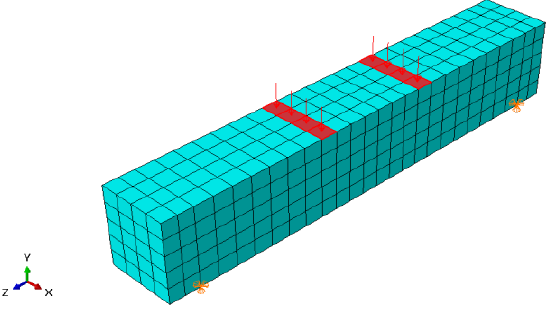
Figure 10. Application of load and support conditions for the beam in ABAQUS.